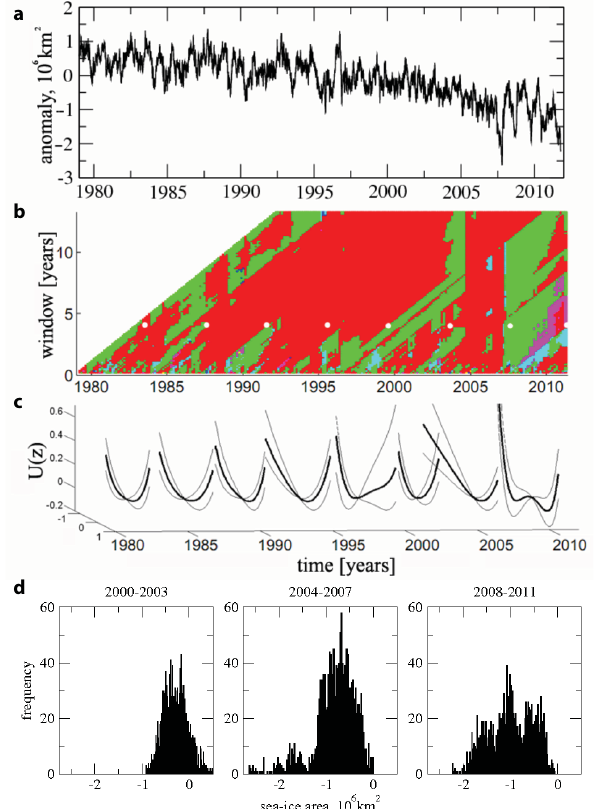
Fig. 3. Analysis of Arctic sea-ice area. (a) Sea-ice area anomaly, daily data with mean seasonal cycle removed. (b) Contour plot of number of detected states, where red=1 detected state, green=2, cyan=3, magenta = 4. Results plotted as a function of sliding win- dow length at the end of the window. (c) Reconstructed potential curves of eight 4-yr time intervals, corresponding to the white dots in (b) . Here z is sea-ice area fluctuation on a shifted scale. Faint lines are potential curves derived from error estimates on the coef- ficients of the polynomial potential function (for details see Livina et al., 2011). In the penultimate interval 2004–2007, a second state starts to appear and in the final interval 2008–2011 there are two states of comparable stability. (d) Histograms of the data for 2000– 2003, 2004–2007, and 2008–2011 from which the corresponding potential curves are derived (see